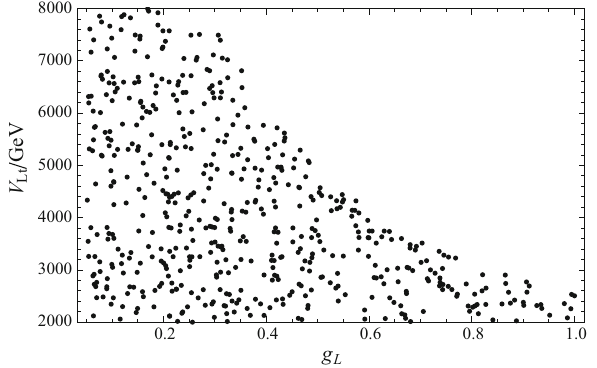
Fig. 3 With m 2 = 1000GeV , M Lf = 10 4 GeV 2 , S 2 m = 13TeV 2 , tan β = 5 . 0, tan β L = 2 . 0, and g L = 1 nuclei Au versus m 1 with V Lt = 3000GeV (solid line) and 6000GeV (dotted line)